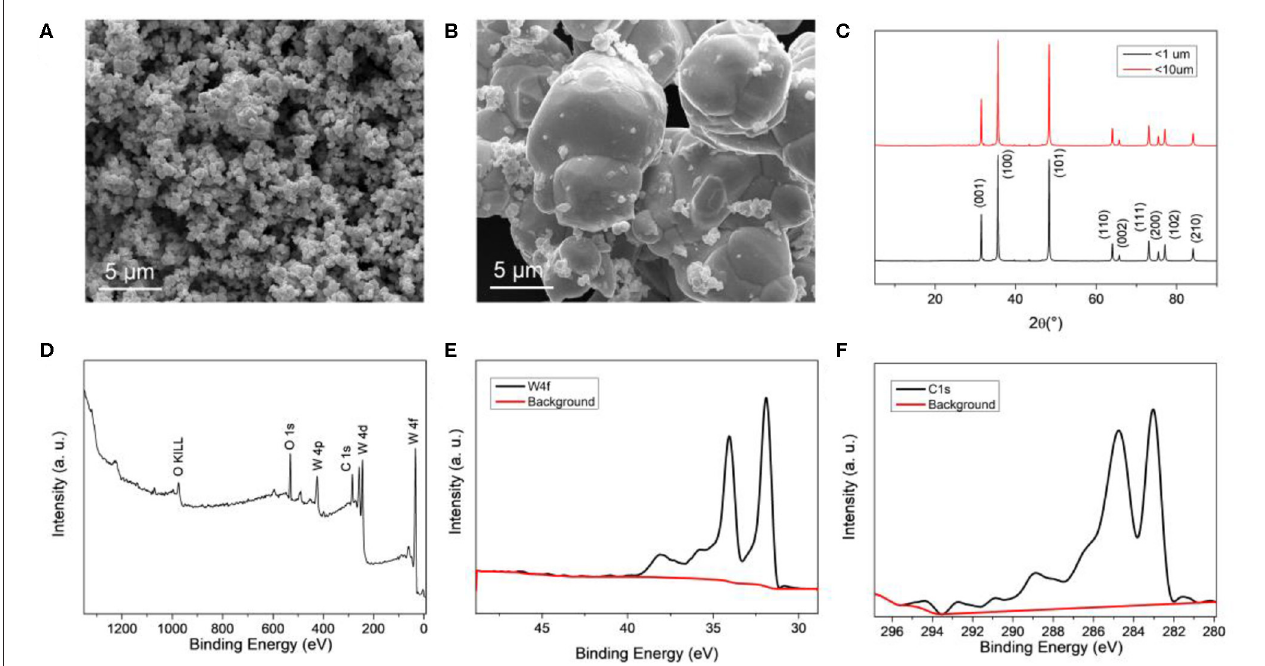
FIGURE 1 | SEM image of WC-1 (A) and WC-2 (B) ; XRD pattern (C) and XPS spectra (D–F) of